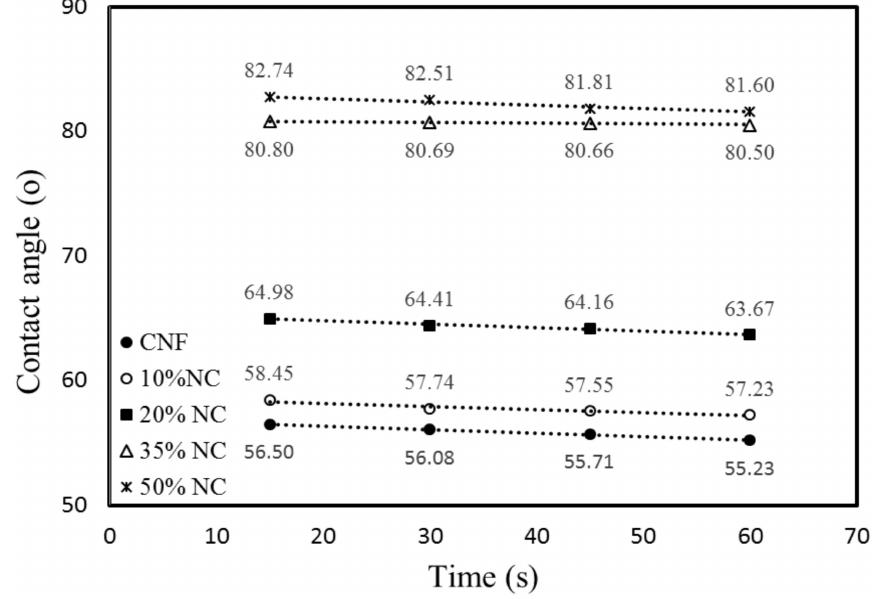
Figure 6. Surface water contact angle of CNF-NC films containing 0, 10, 20, 35 and 65 wt % of NC.